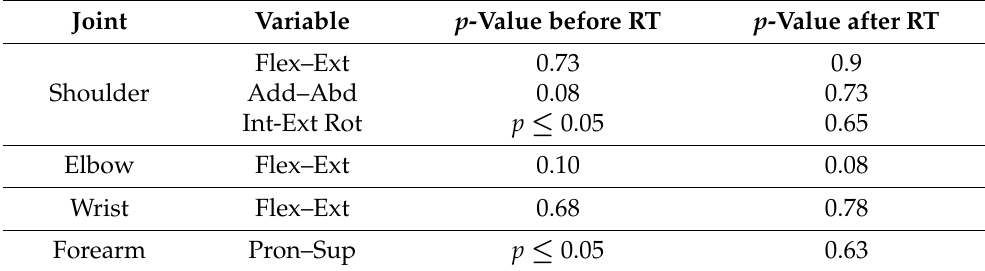
Table 15. Angular velocity Wilcoxon test of the paretic and non-paretic limb in the Apley Scratching Test before and after the rehabilitation